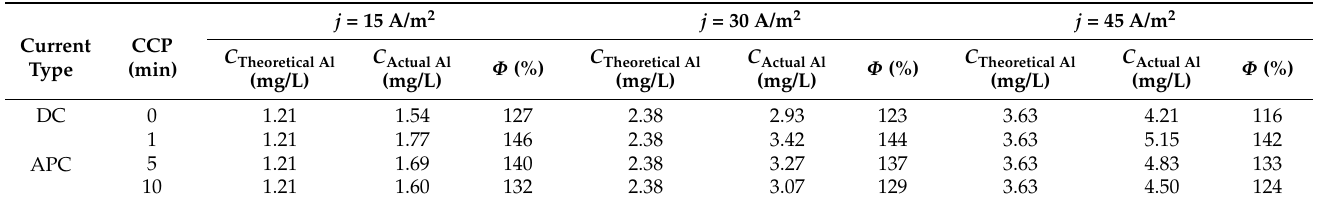
Table 2 represents the Al dissolution after operating the EC − filtration system for 90 min. Table 2. Effects of the current density and CCP on Al dissolution after operating the EC − filtration system for 90